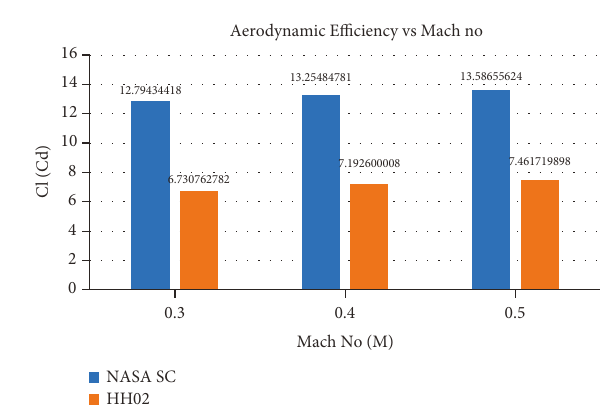
Figure 10: Aerodynamic efficiency vs. Mach no.